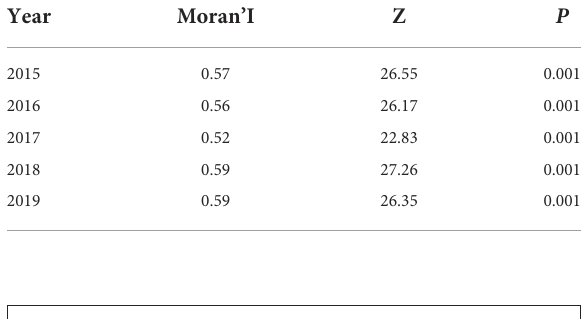
FIGURE3 Average of spatial clustering for PM 2.5 concentrations from 2015 to 2019.